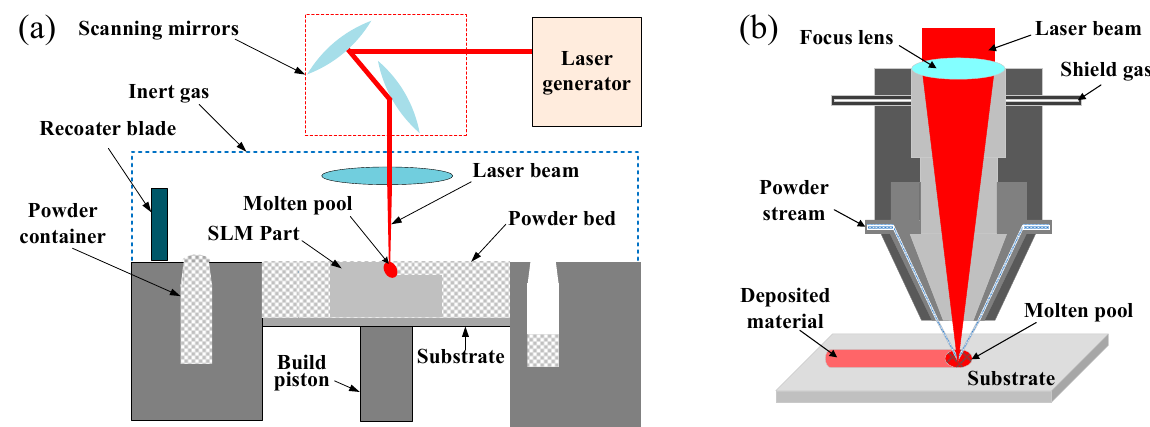
Figure 1. Schematic illustration of ( a ) powder bed fusion and ( b ) direct laser deposition LAM. In LMD process, the continuous wave (CW) laser, which is a common laser mode used presently, inputs relatively low heat into the substrate that attributes to the obtaining of high temperature gradient and high cooling rate during laser beam scanning compared